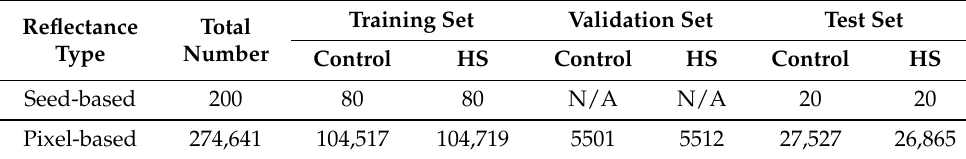
Table 1. Number of samples in each dataset.